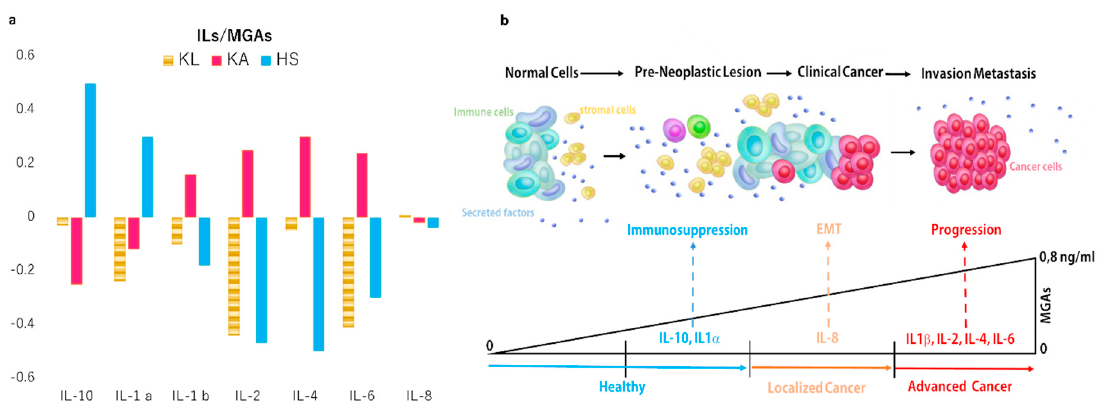
Figure 3. Interplay between metabolism and cytokines production. ( a ) Graphic representations of interleukins patterns in the function of MGAs secretion was reported as coefficient correlation values for each secreted cytokine. Moreover, based on the correlation value observed in the reassuming graphic ( b ) suggests a potential interpretation. In particular, in a healthy group of secretome samples, two classes of subjects are evident as distinguished for the ILs-pattern of IL-10 and IL-1. The cancer group is distinguished in localized and advanced phases of the disease. In the secretome of localized cancer BDCs, IL-8 appears to be prevalently secreted in respect to other ILs. In the advanced cancer cases, the secretome of BDCs are prevalent to the secretion of IL-1 β , IL-2, IL-4, and IL-6 as a consequence of the increased levels of MGAs inducing NFKB by the receptor for advanced glycation end-product (RAGE) way and relative interleukins cascade